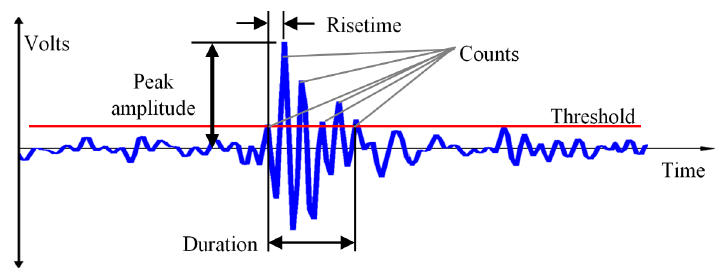
Figure 1. Characteristics of AE Signal.